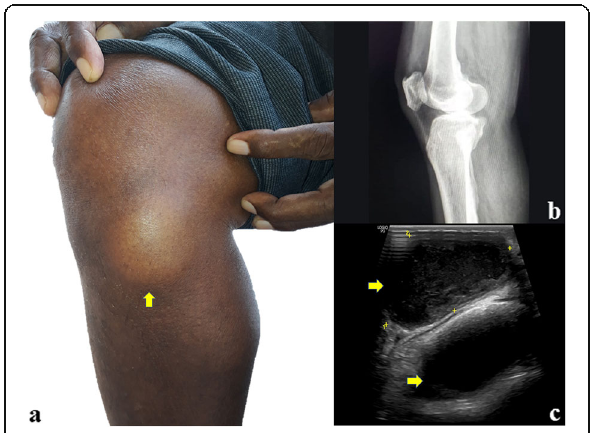
Fig. 1 a Clinical picture of patient showed a nodule in subcutaneous location below right knee joint in anteromedial aspect with firm consistency and measuring 4x3cm approximately. b X-ray revealed no bony involvement; c USG of medial aspect of right knee showed two well defined oval anechoic thick-walled lesions measuring 4.5 × 2.6 cm and 4.0 × 2.4 cm in the subcutaneous plane, below knee joint